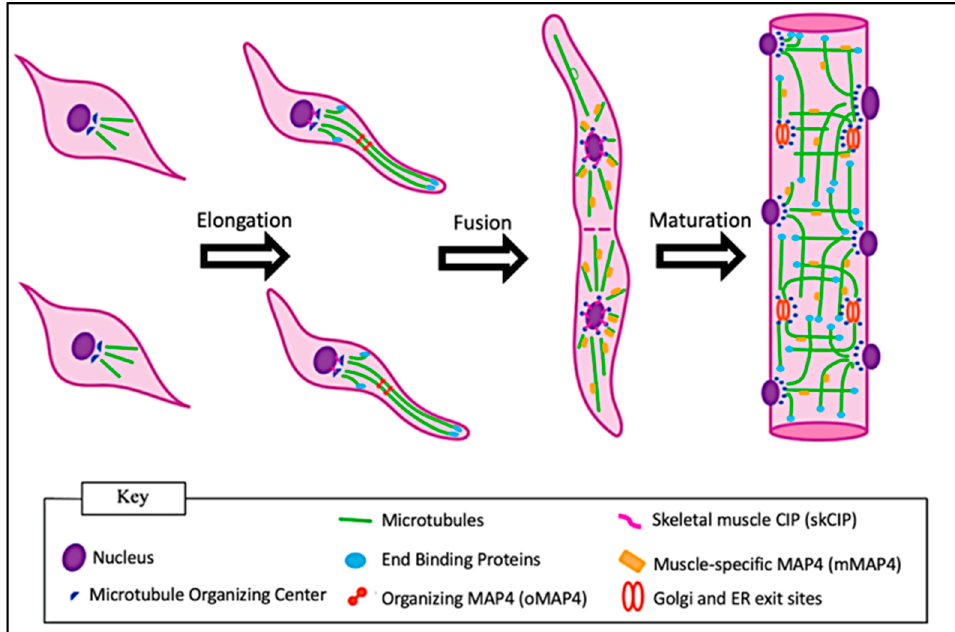
Figure 2. Changes in microtubule structures during myogenesis. Initially, microtubules within myoblasts extend in a star-like projection from a peri-nuclear-associated MTOC. Following myoblast elongation, the MTOC is redistributed around the nucleus and the microtubules form a paraxial array. Following myoblast fusion, microtubules are stabilized, but remain dynamic in myofibers.